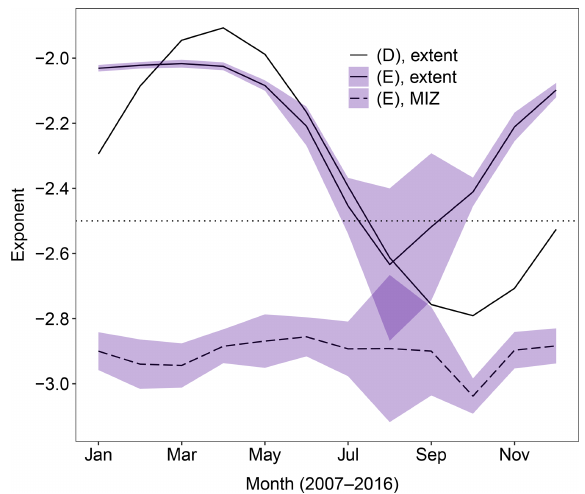
Figure 10. Annual variation in α (top) averaged over 2007–2016 for two simulations with variable α . The plots show results for an α which varies depending on time through the year (D, no ribbon) or on the sea ice concentration (E, blue ribbon). Results are given as the mean α for the total sea ice extent (solid) and MIZ only (dashed). The mean α is taken as the equally weighted average across all grid cells where the sea ice concentration exceeds 5% (total extent) or is between 15% and 80% (MIZ only). The imposed annual oscillation in α is identical for all grid cells for (D); hence the MIZ behaviour has not been plotted as it will be identical to the annual oscillation in α across the total sea ice extent. The ribbon shows, in each case, the region spanned by the mean value plus or minus 2 times the standard deviation for each simulation. Both set-ups show an annual oscillation in the value of α averaged over the total sea ice extent. For experiment (E), no obvious annual trend in the mean value of α can be seen when averaged over the MIZ, though the interannual variation is at a maximum during the peak melting season between July and